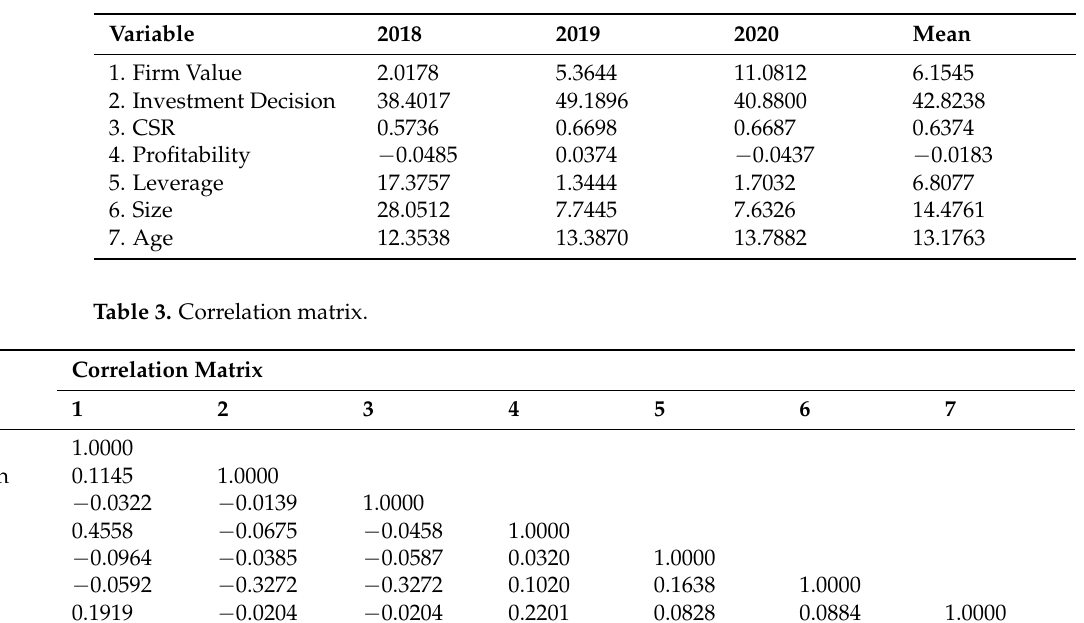
Table 2. Descriptive statistics (mean values).